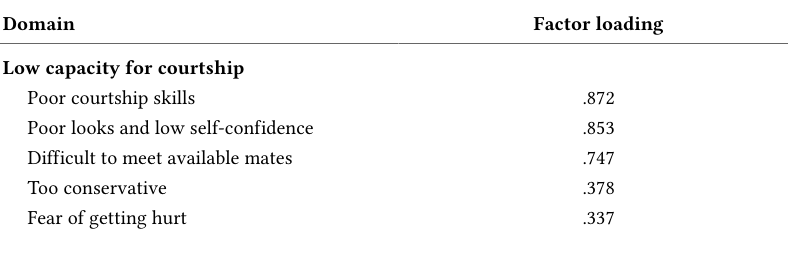
The Domains Derived From Applying Second Order Principal Components Analysis in Study 2 Domain Factor loading Low capacity for courtship Poor courtship skills .872 Poor looks and low self-confidence .853 Difficult to meet available mates .747 Too